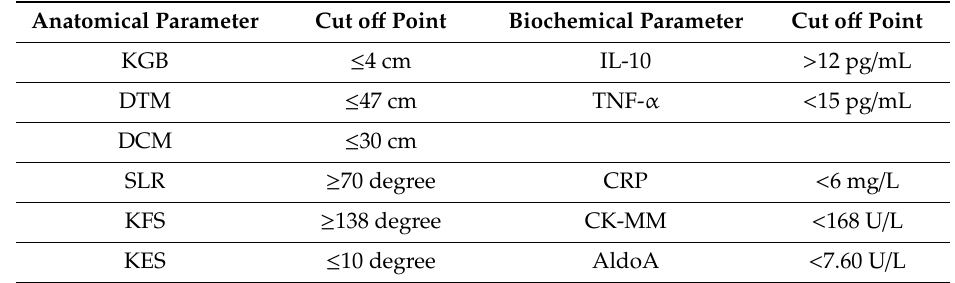
Table 3. Analysis of cut o ff points of anatomical and biochemical parameters for the calculation of relative risk ratio.